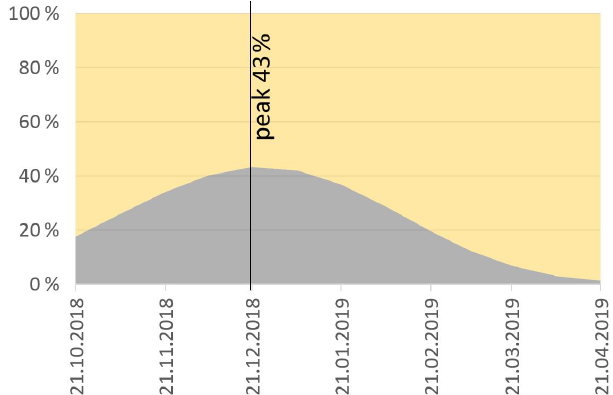
Figure 9. Evolution of the share of illuminated and shaded areas from 21 October to 21 April (exemplarily shown for the winter 2018/19 for the perimeter 2019). The share was calculated using the function “hillshade” (with cast shadows) in ArcGIS for every 6th and 21st day of the months relying on a DEM with a 2m res- olution, sun azimuth and sun altitude (for SPOT acquisition time at 10:00UTC for Davos from http://sonnenverlauf.de, last access: 18 February 2021). The values between the 6th and 21st of each month were interpolated.